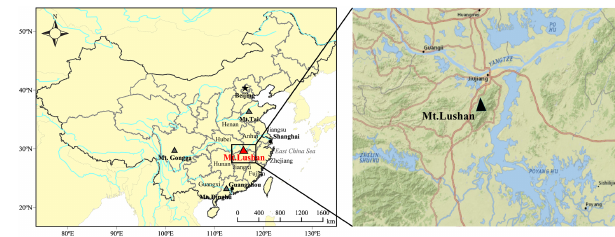
Figure 1. The location of Mt. Lushan and the adjacent Yangtze River and Poyang